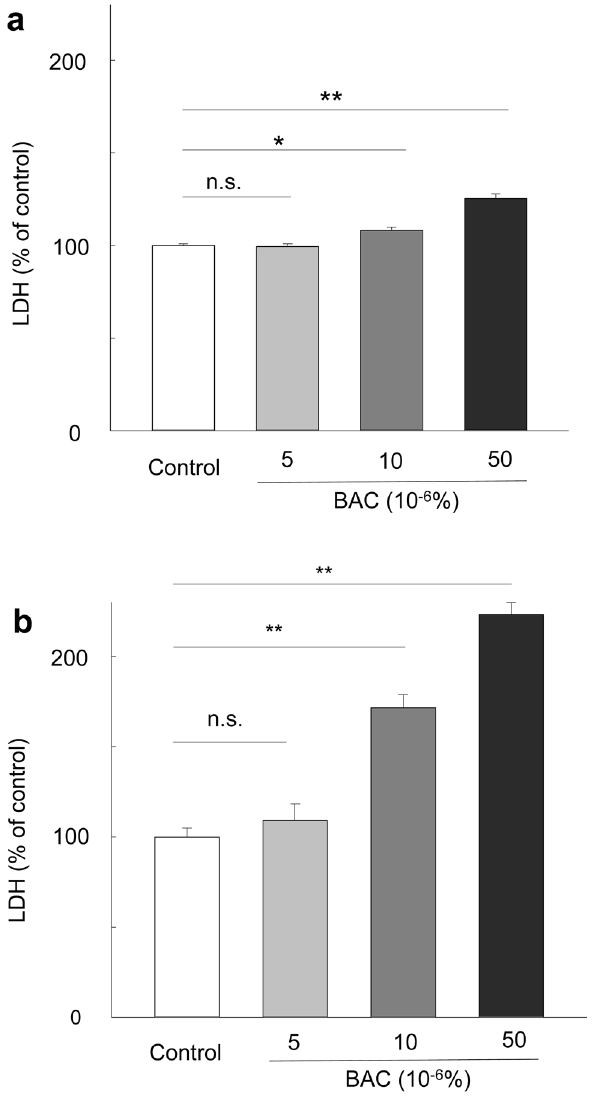
Figure 1. Cytotoxicity of BAC for HTFs and HCE cells. HTFs ( a ) or HCE cells ( b ) were deprived of serum for 24 h and then incubated in the absence (Control) or presence of the indicated concentrations of BAC for 24 h, after which the amount of LDH released into the medium was measured. Data are expressed as a percentage of the control value and are means + s.e.m. of five independent experiments. * p < 0.05, ** p < 0.01; n.s., not significant (Holm-Sidak post hoc